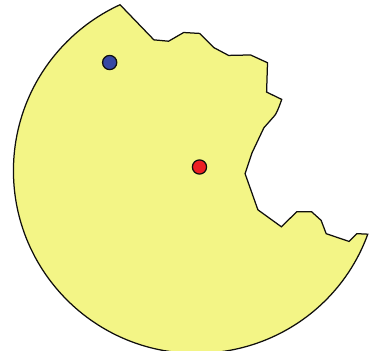
Figure 6: Example of geographic masking technique (i.e., random placement within a circle) using an additional spatial filter to constrain displacement. The red dot represents the original location; the yellow area represents all possible locations for the masked location; and the blue dot represents one possible masked location selectedrandomly.Thisfiltercanbeusedtoavoidplacementinareas wherelogicallynopopulationresides(suchaswaterbodiesorparks) ortolimitdisplacementtoaparticularenumerationunit(suchasthe same census tract or postal